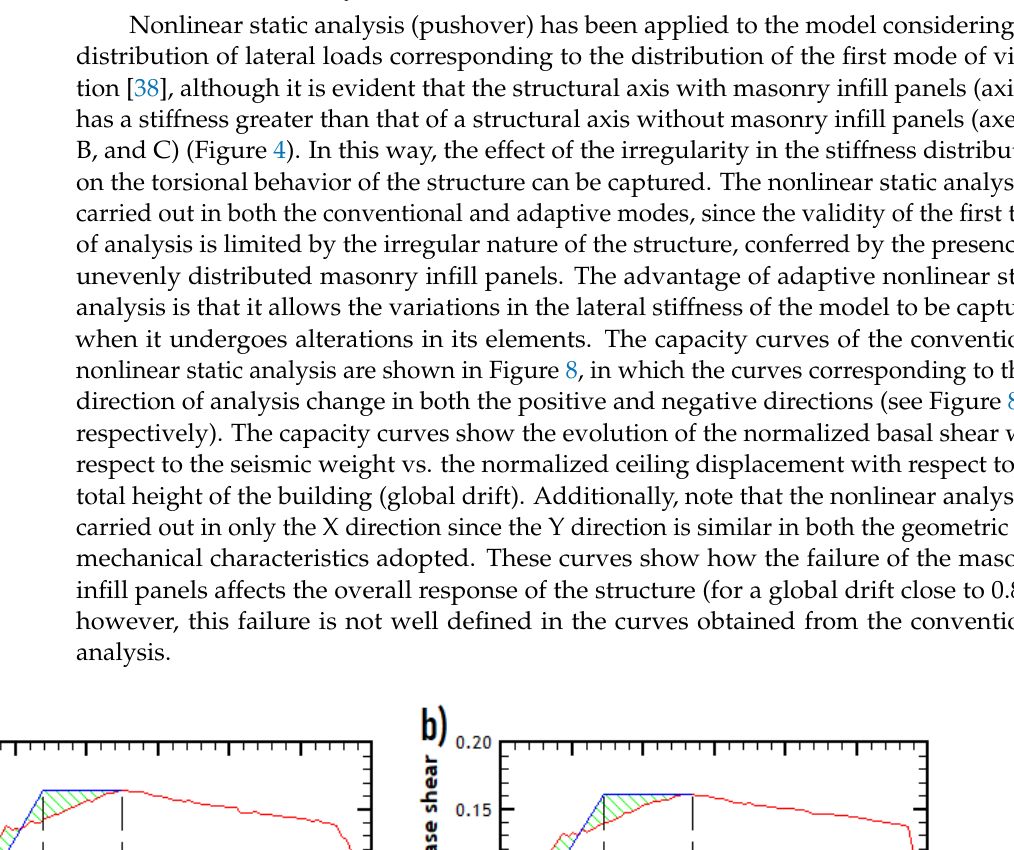
Figure 9. Resulting capacity and idealized curves obtained from adaptive pushover analysis: ( a ) lateral forces (+) and ( b ) lateral forces ( − ).